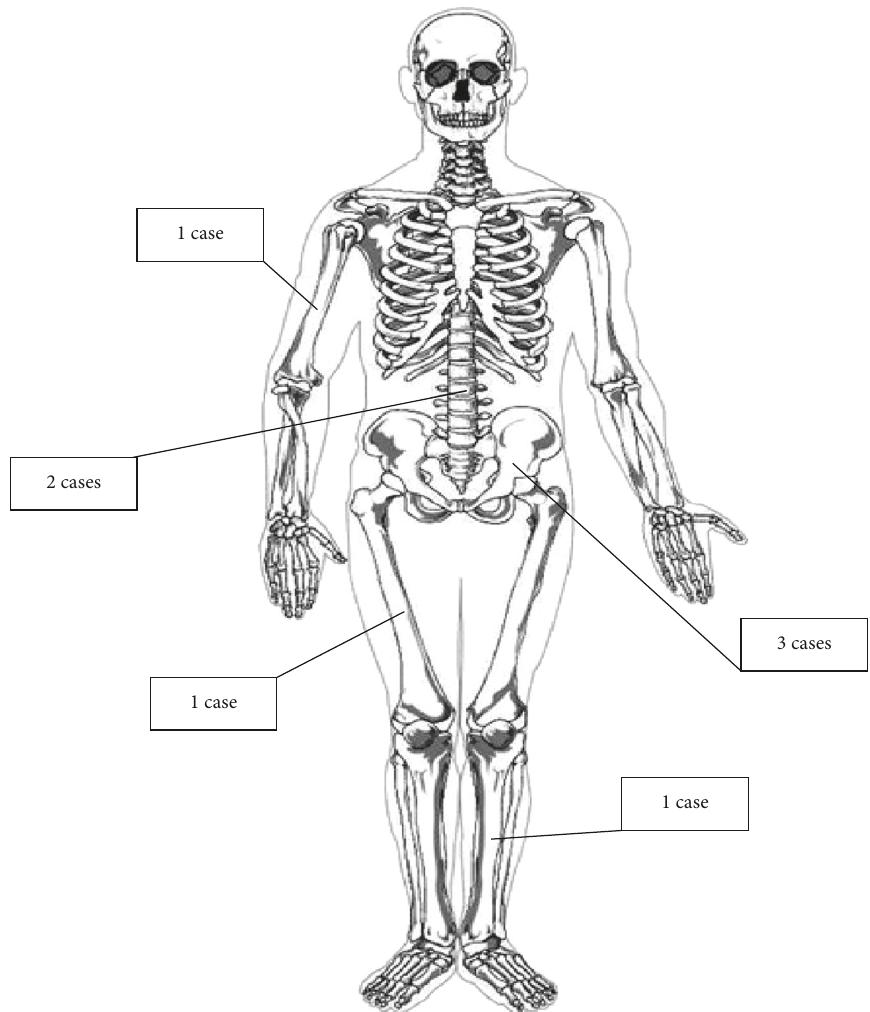
Figure 1: Absolute numbers of the anatomical distribution of bone CE lesions in our